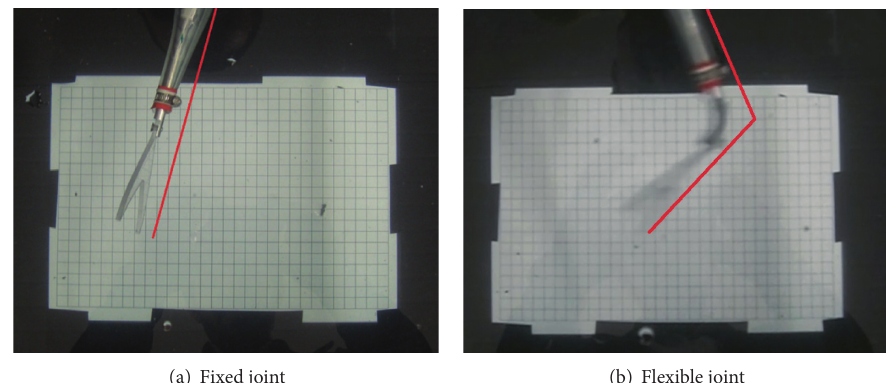
Figure 8: Connections of the caudal fin to the tail peduncle.